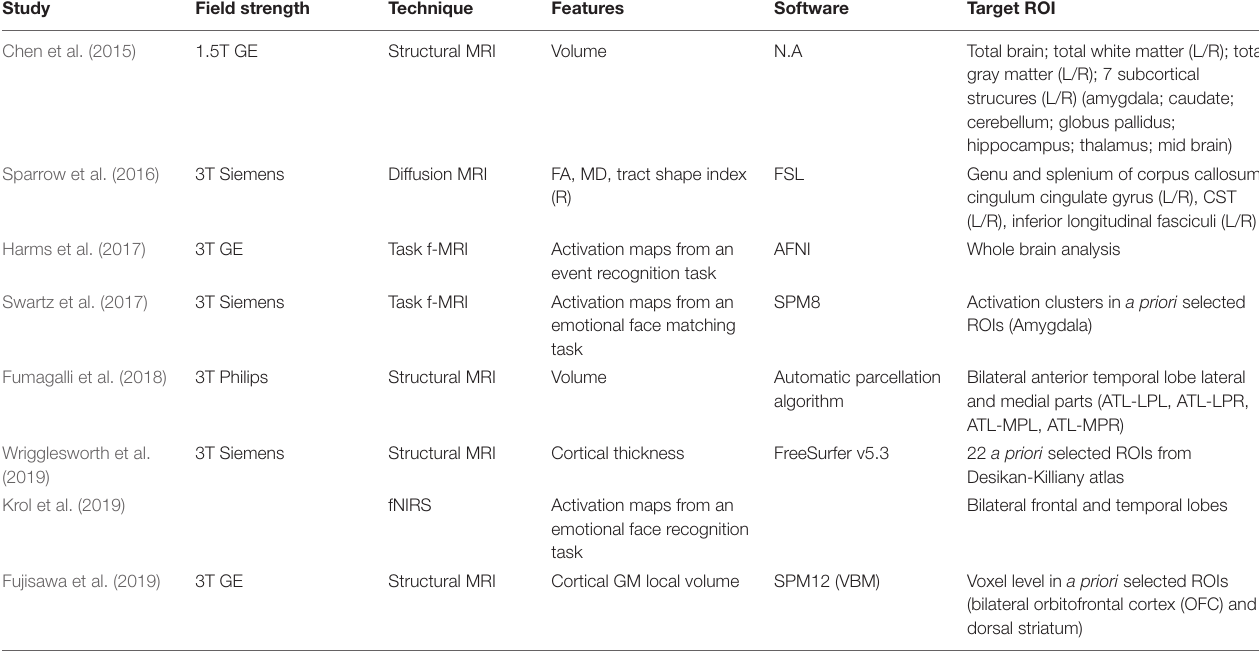
TABLE 3 | Description of neuroimaging